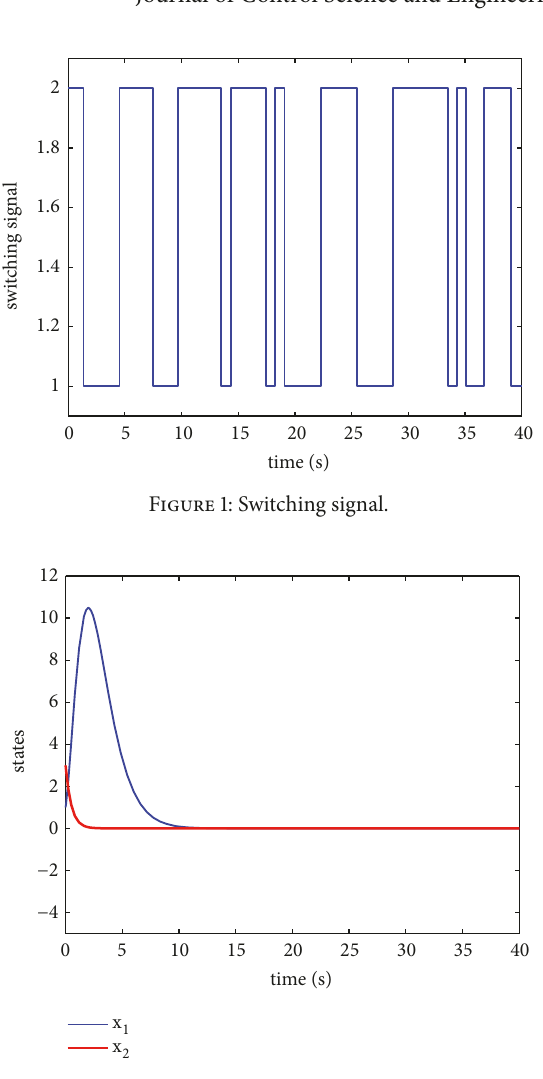
Figure 2: The response curve of the states in example. Table 1: Comparison with the result in